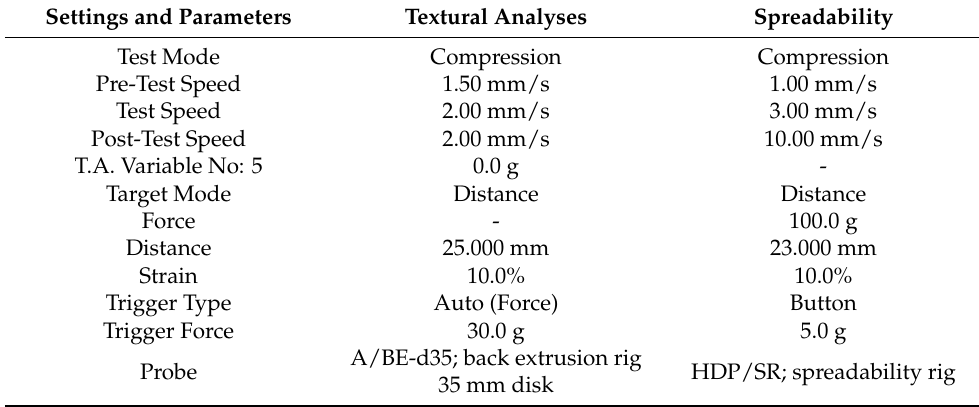
Table 7. Settings and parameters used in textural and spreadability analyses of the blank and extract